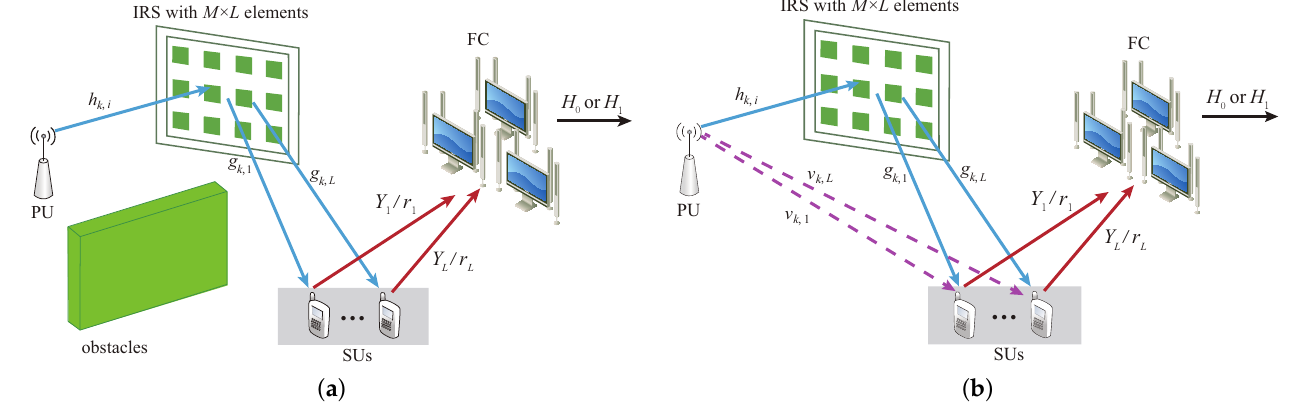
Figure 1. The system model of IRS-enhanced CSS. ( a ) without direct links; ( b ) with direct links. The channels from the PU to the k -th element in the i -th group, from the k -th element in the i -th group to the i -th SU (SU i ) and from the PU to the SU i are denoted by h k , i , g k , i , and v i , respectively, where k ∈ { 1, · · · , M } , i ∈ { 1, · · · , L } . Since the channels between different ele- ments and the PU are almost the same, the channel differences between different groups and the PU can be ignored, i.e., h k , i = h k . Rayleigh fading is used to model the channels. Thus, the corresponding channel-envelope | h k | ∼ Rayleigh (cid:1) | ∼ Rayleigh (cid:0)(cid:112) β | v , where β h , β g , i and β v , i are the path-loss i v , i